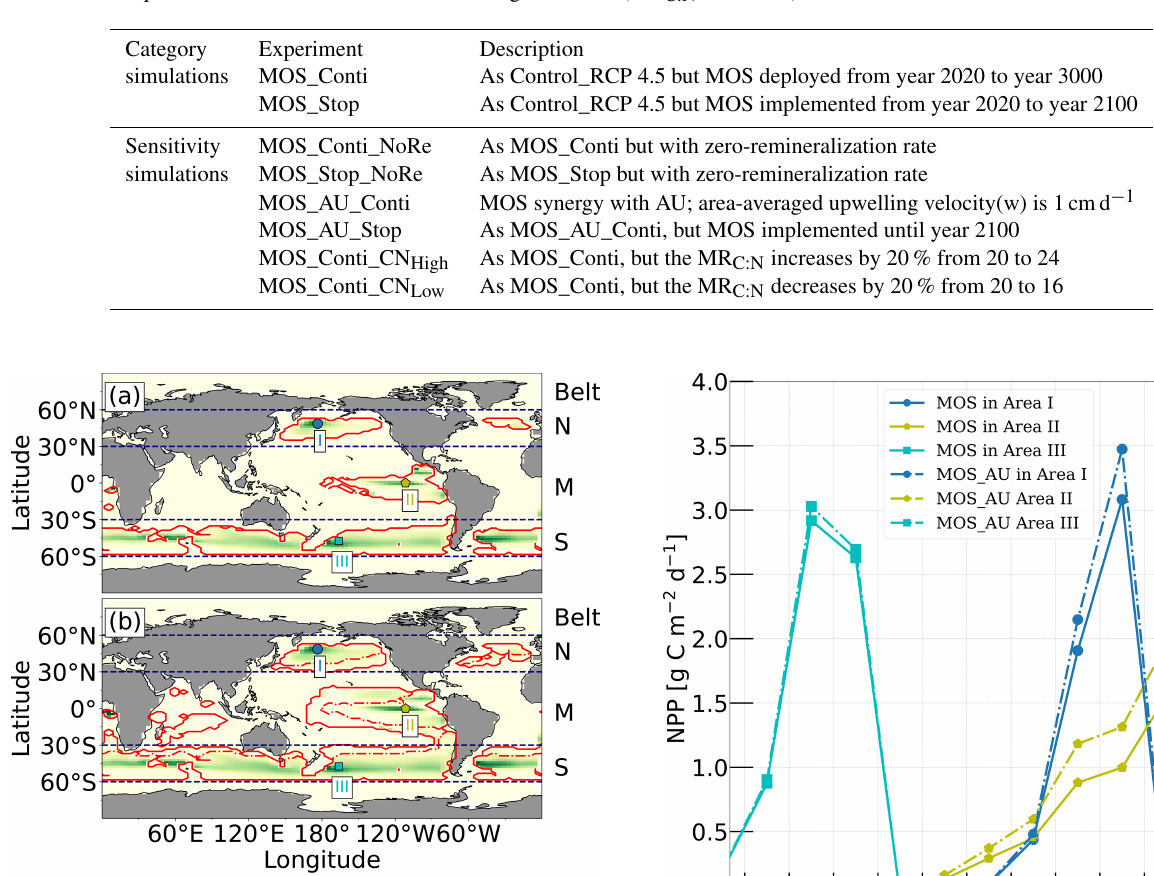
Table 3. Description of the model experiments. “Stop” represents the termination of the simulation in year 2100; “Conti” represents the con- tinuous MOS deployment till year 3000; “AU” represents artificial upwelling; NoRe represents zero remineralization of sunken macroalgal biomass; CN represents the molar C : N ratio of macroalgal biomass (MR C : N in Table 1).